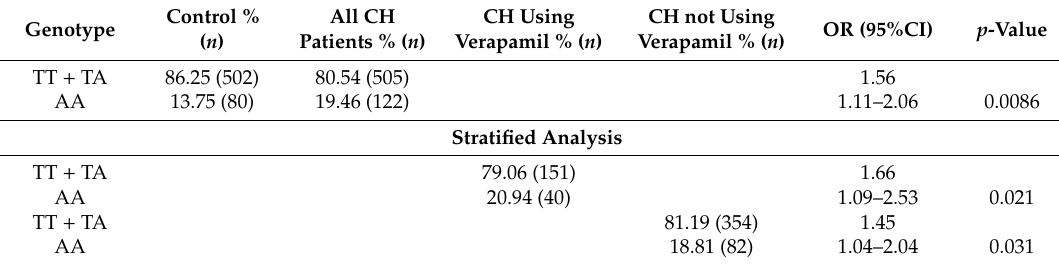
Table 5. Analysis of rs1531394 in patients using